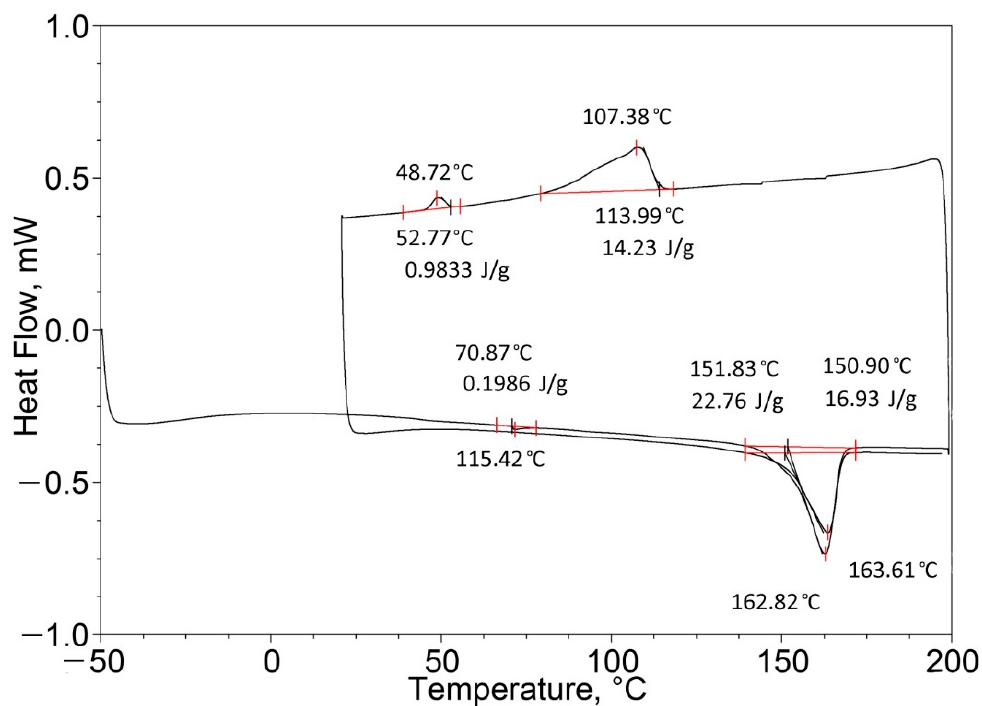
Figure 12. Melting-crystallization-melting diagram (DSC scan curves) of the 25% PP-75% EPTSR polymer blend produced by SEDS method.